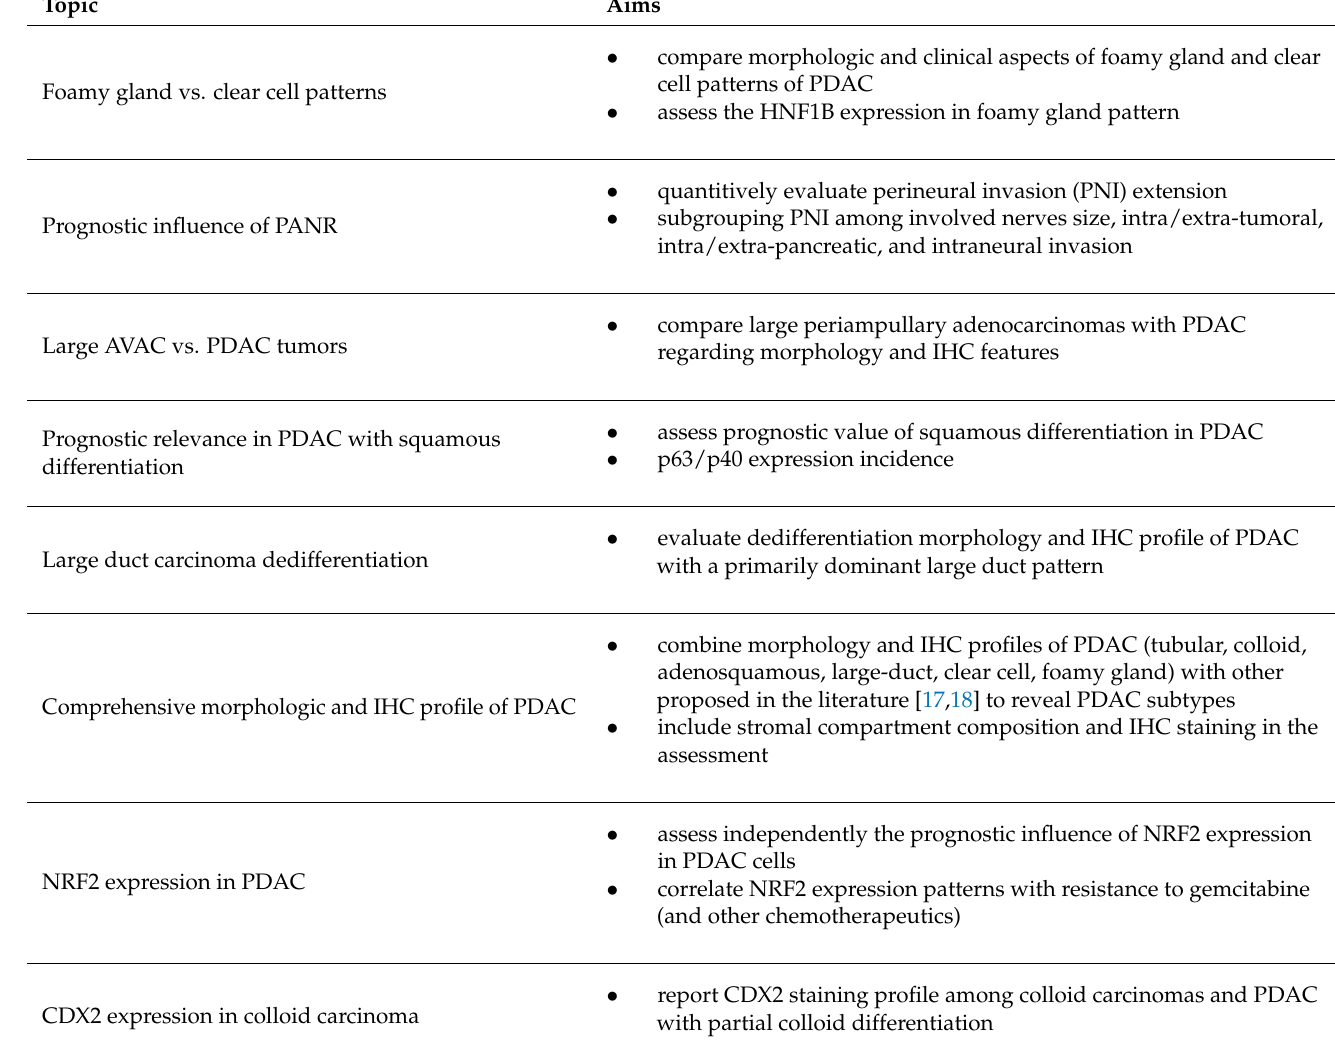
Table 5. Future research proposals in PDAC pathology. HNF1B, hepatocyte nuclear factor-1 β ;